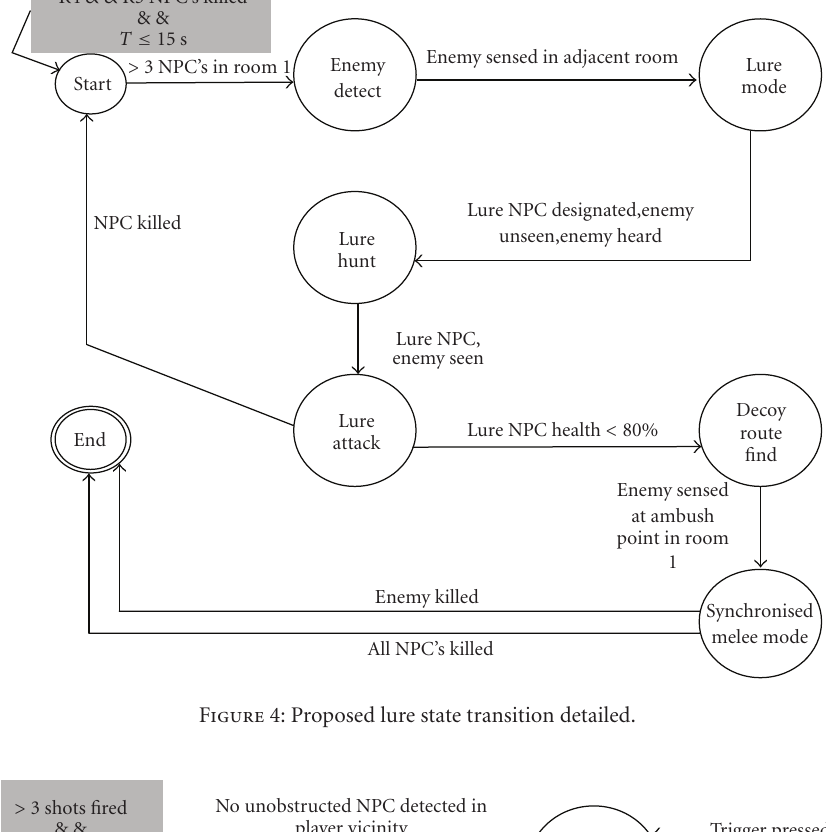
Figure 4: Proposed lure state transition detailed.